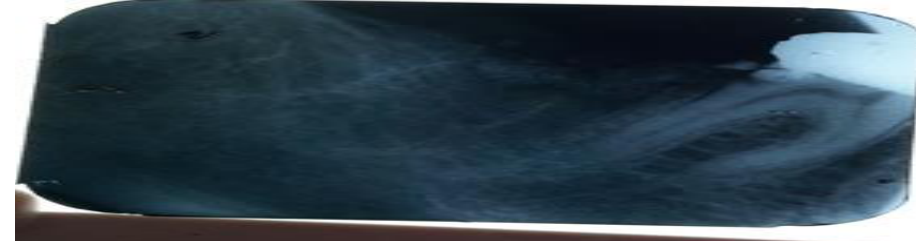
Figure (5): The postoperative X –ray after 1